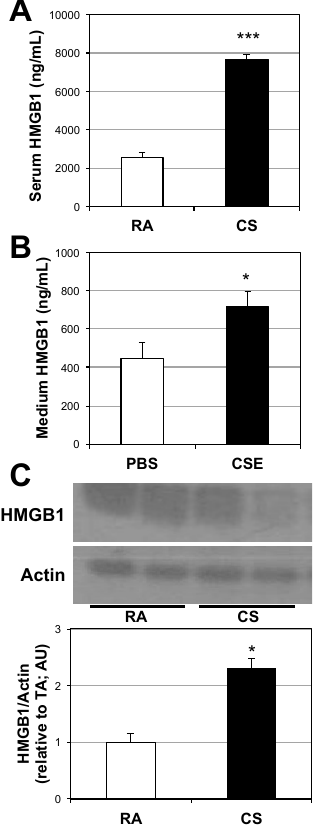
Figure 2. Cigarette smoke exposure increases HMGB1 in muscle. The 12–14-week-old male C57Bl6 mice were exposed to cigarette smoke (CS) or room air (RA) daily for 6 days. HMGB1 was then determined from serum ( A ) ( n = 6); HMGB1 protein was also measured from cell culture medium of primary macrophages treated with PBS or cigarette smoke extract (CSE) ( B ) ( n = 5) via ELISA or Western blot from alveolar macrophages from mice following smoke exposure ( C ) ( n = 6). *** p < 0.001; * p < 0.05 for CS/CSE vs. RA.